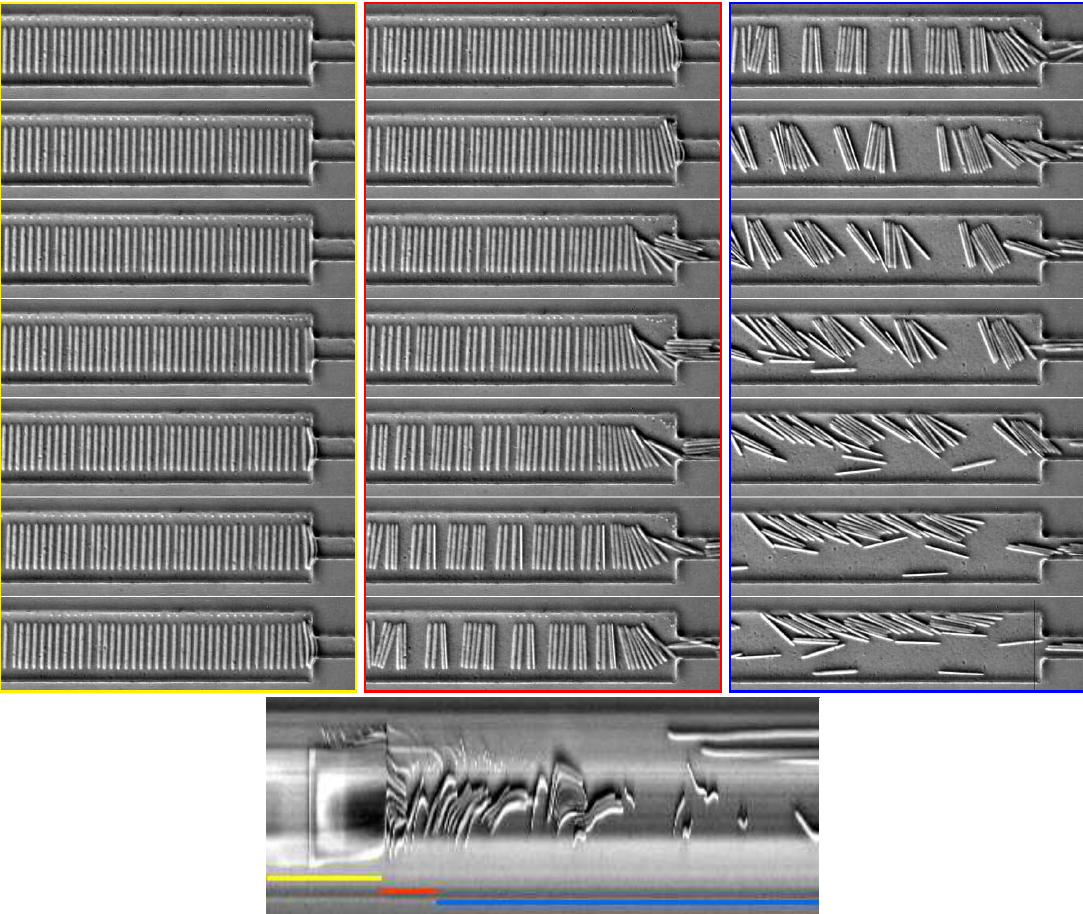
Figure 14. Time series of images showing the behavior of a suspension of 200 µ m-long fibers oriented perpendicular to the flow. Flow goes from left to right in the pictures. The first column focuses on the initial times (0.85 s between frames); the second shows the lateral symmetry breaking on a longer time scale (6 s after applying the flow, 0.4 s between frames); and the third one shows later times (10 s after applying the flow, 1.7 s between frames). The suspension changes from an ordered spatial organization to a disorganized state, which evolves very slowly. The bottom image is a spatio-temporal representation of a cut perpendicular to the flow direction. Time is represented as the x -axis going from left to right ( ≈ 12 s in total), whereas the y -axis represents a line drawn in black on the last image. Note that the total number of images treated here is smaller than the one used for Figure 13, resulting in a smaller spatio-temporal image. The corresponding video is available in Supplementary Materials Video